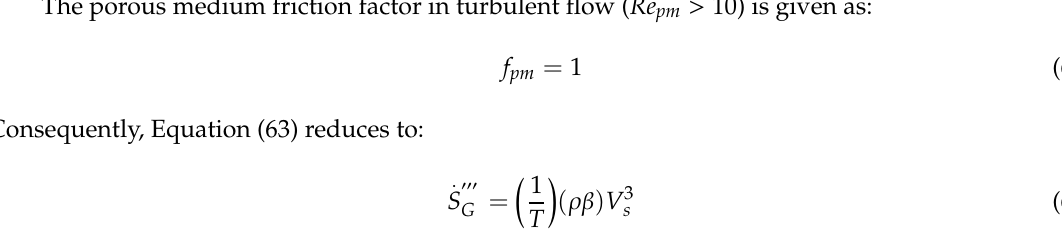
Figure 9. One-dimensional flow in consolidated porous medium.